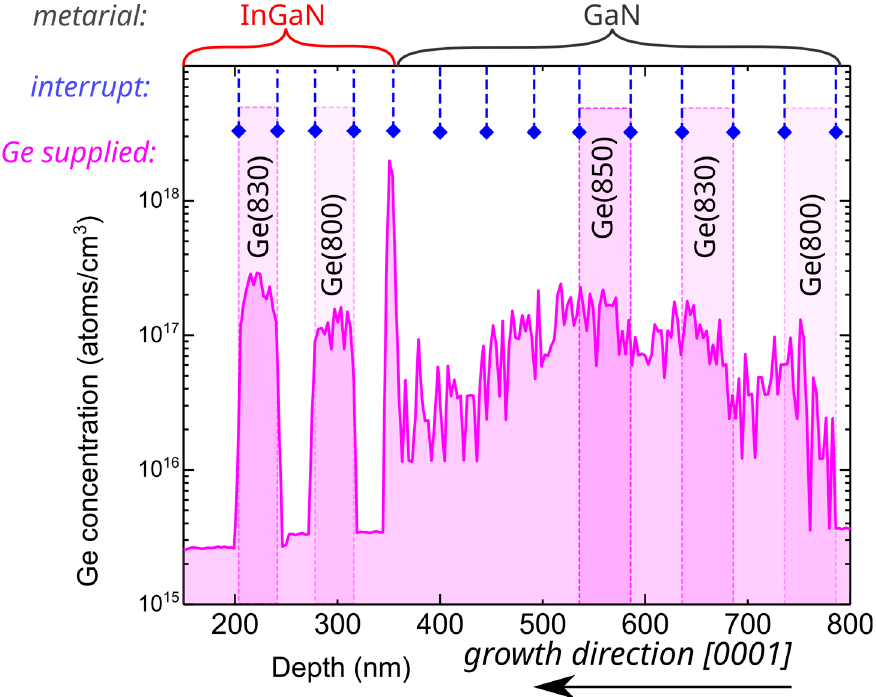
Figure 1. Germanium concentration measured by SIMS as a function of depth for a stack of InGaN:Ge and GaN:Ge layers separated by layers of the same composition that were intentionally undoped. InGaN and GaN parts of the crystal are marked above the plot. Places where the germanium effusion cell was opened are marked by additional shading with germanium cell temperature in Celsius. Places where all atomic fluxes were closed to allow for excess gallium and indium desorption are marked with dashed blue lines and a diamond symbol.